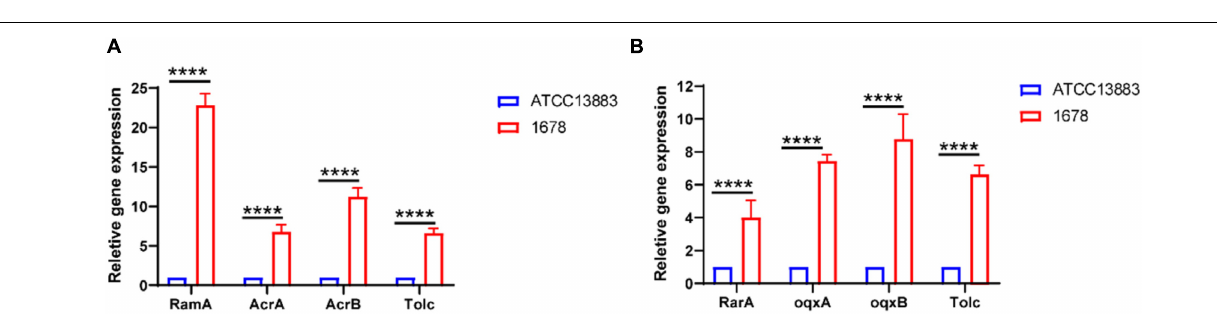
FIGURE 2 | Overexpression of AcrAB and OqxAB in clinical K. pneumoniae 1678 isolate. The expression levels of AcrA/B (A) , OqxA/B (B) , and related transcriptional regulators was determined by qRT-PCR. The K. pneumoniae ATCC13883 is used as the reference strain (expression = 1.0). The data represent the mean standard deviation for three independent biological replicates. Differences between different strains, regarding related gene expression, were statistically analyzed using a two-tailed Student’s t -test with Bonferroni correction. **** p <